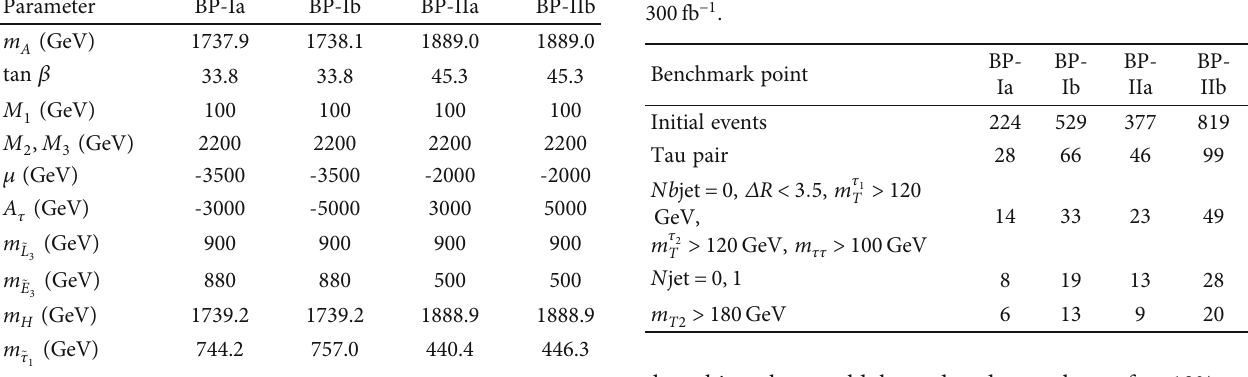
Table 8: Cut fl ow of events from benchmark points BP-Ia, BP-Ib, BP-IIa, and BP-IIb for a con fi guration